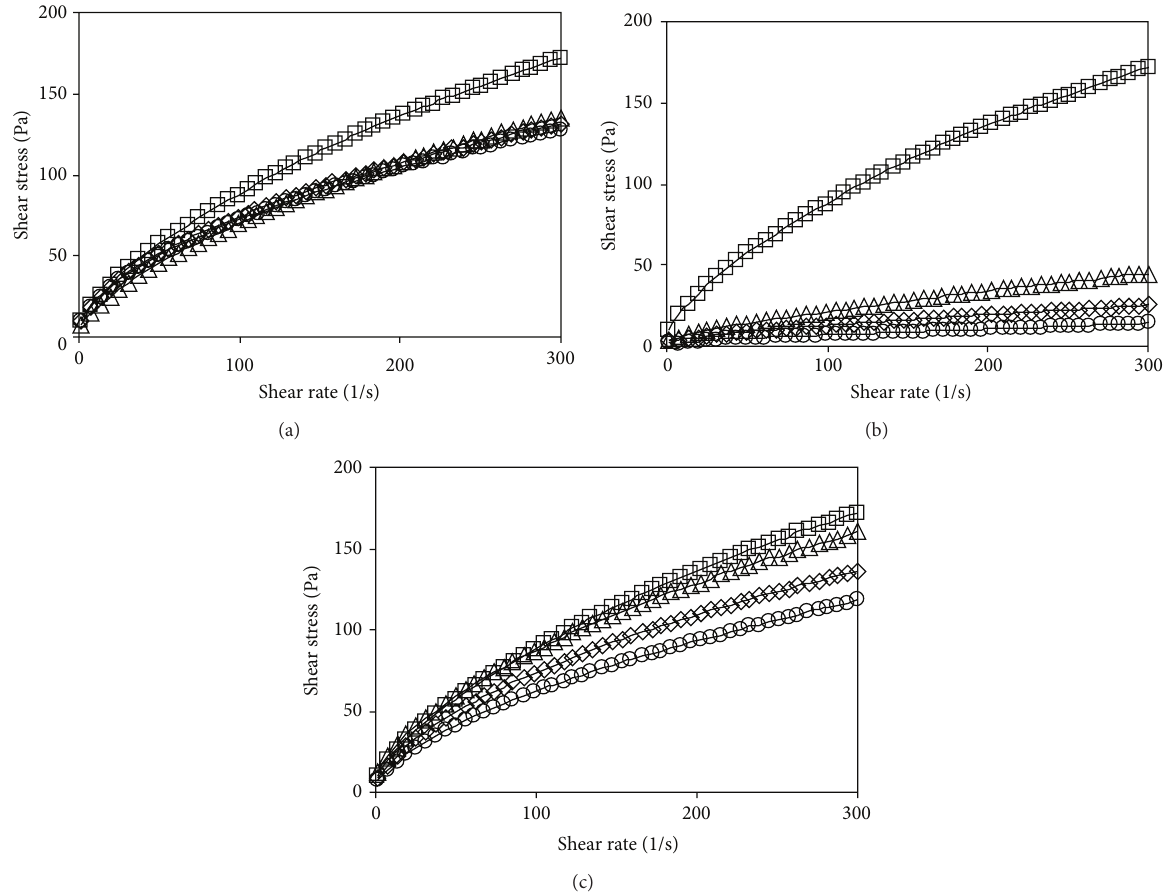
Figure 2: Flow curves of native starch and blends with (a) low-saccharified maltodextrin, (b) medium-saccharified maltodextrin, (c) high-